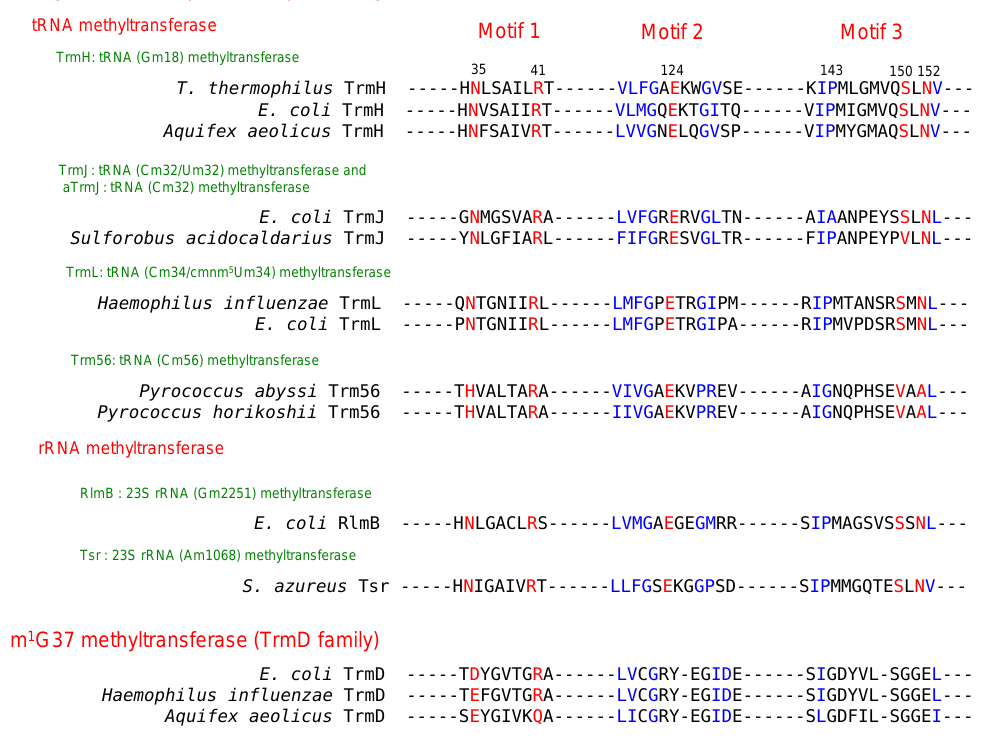
Figure 3. The conserved motifs in the TrmH (SpoU) and TrmD families. The amino acid sequence alignment is based on the reference [3], and has been modified in accordance with biochemical data. Color (blue and red) letters indicate the conserved amino acid residues, reported by Anantharaman et al. [3]. Red letters indicate the amino acid residues that are essential for the methyl-transfer reaction by Thermus thermophilus TrmH. Numbers indicate the positions of amino acid residues in T. thermophilus TrmH. T. thermophilus : Thermus thermophilus ; E. coli : Eshcerichia coli ; S. aureus : Streptomyces aureus